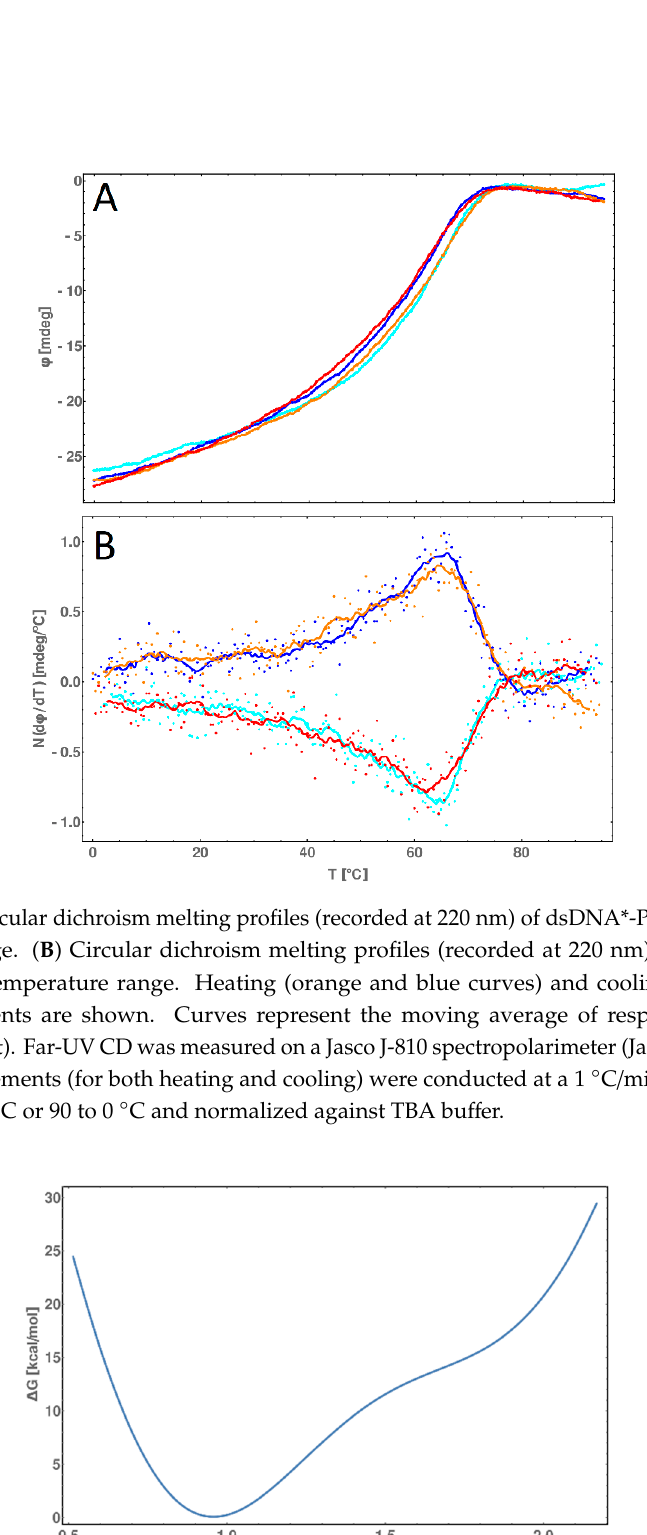
Figure 13. Free energy profile of peptide binding to DNA obtained by a well-tempered metadynamics scheme over 5 µs simulation. The reaction coordinate (RC) represents the distance between the centers of masses of the peptide and the AP-1 interacting site. The bound state is located around 0.9 nm. The calculated binding energy of α -helix to DNA is calculated to be ~10 kcal/mol.